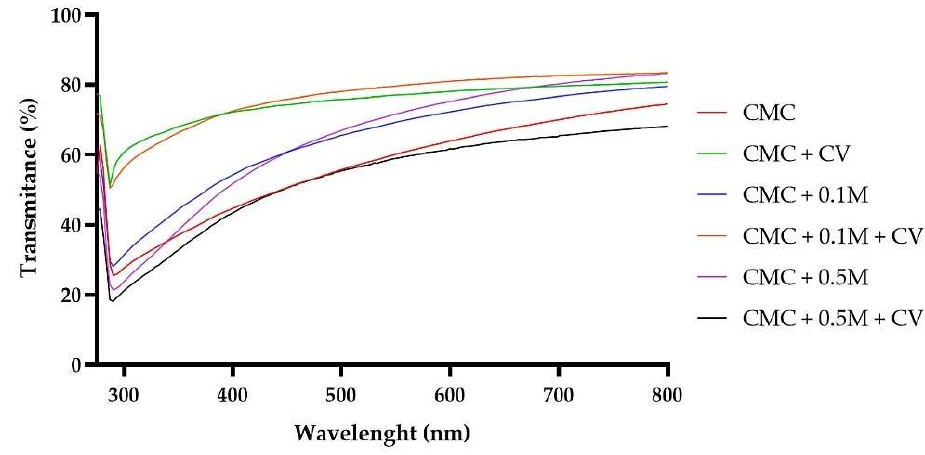
Figure 5. UV-Vis spectra of CMC-based neat and modified films.